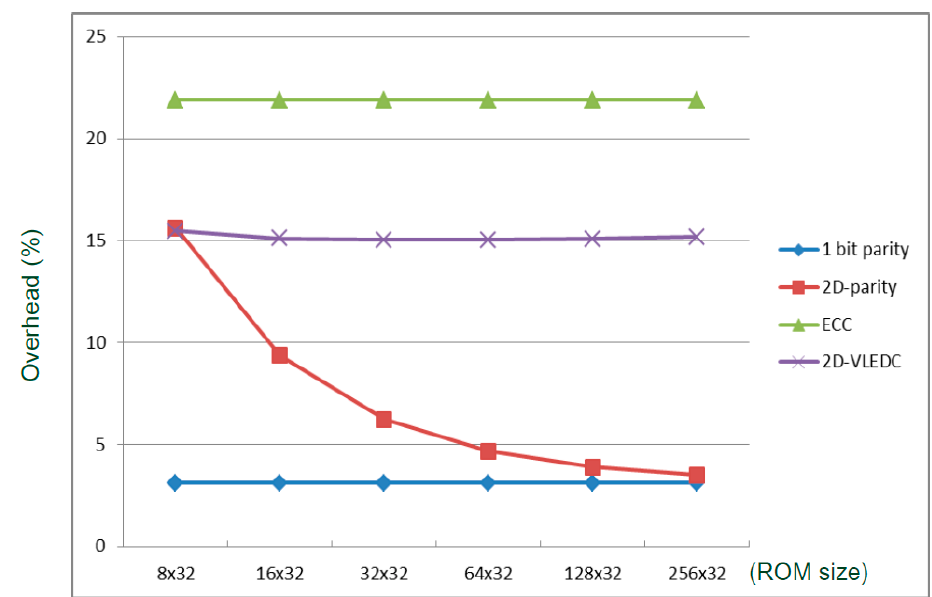
Figure 9. The comparison of the overhead of redundant bits. The overhead was calculated by Equation (2).